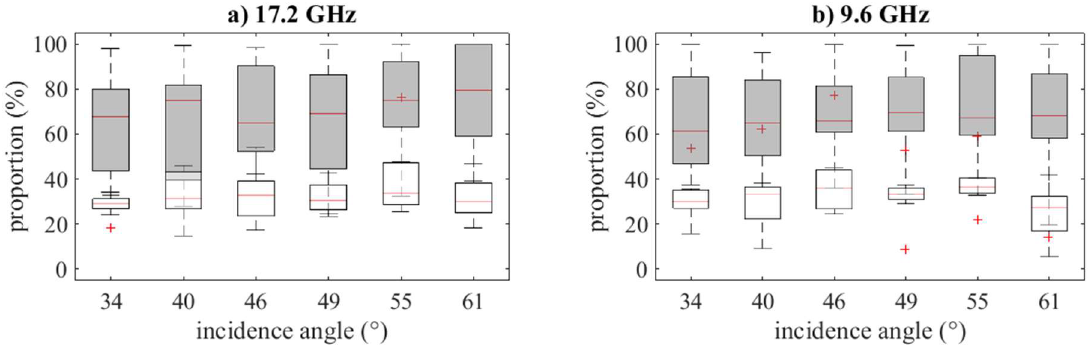
Figure 8. The comparison of the volume scattering proportion for the forested (shaded) and non-forested (white) sites at ( a ) 17.2 GHz, and ( b ) 9.6 GHz.